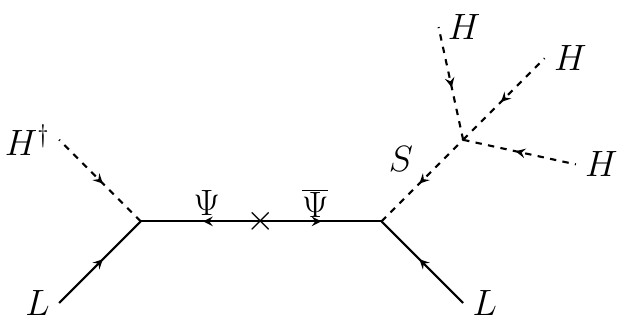
Figure 1 . Tree-level d = 7 neutrino mass diagram, for the model described in [30]. (cid:9) = 3 F S = 4 S 3 = 2